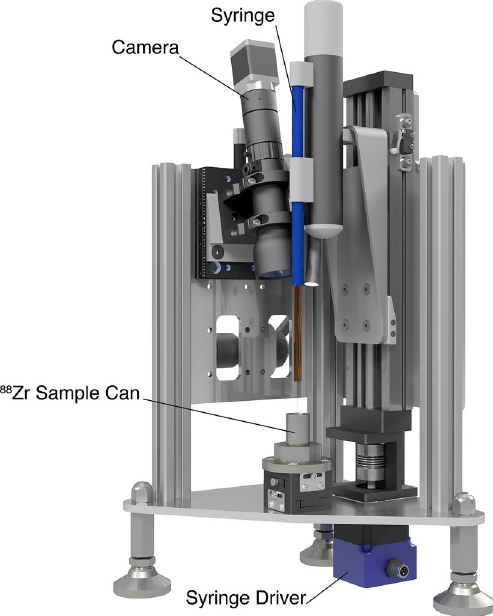
Figure 7. Automated station for transferring of 8 µL sample with 88